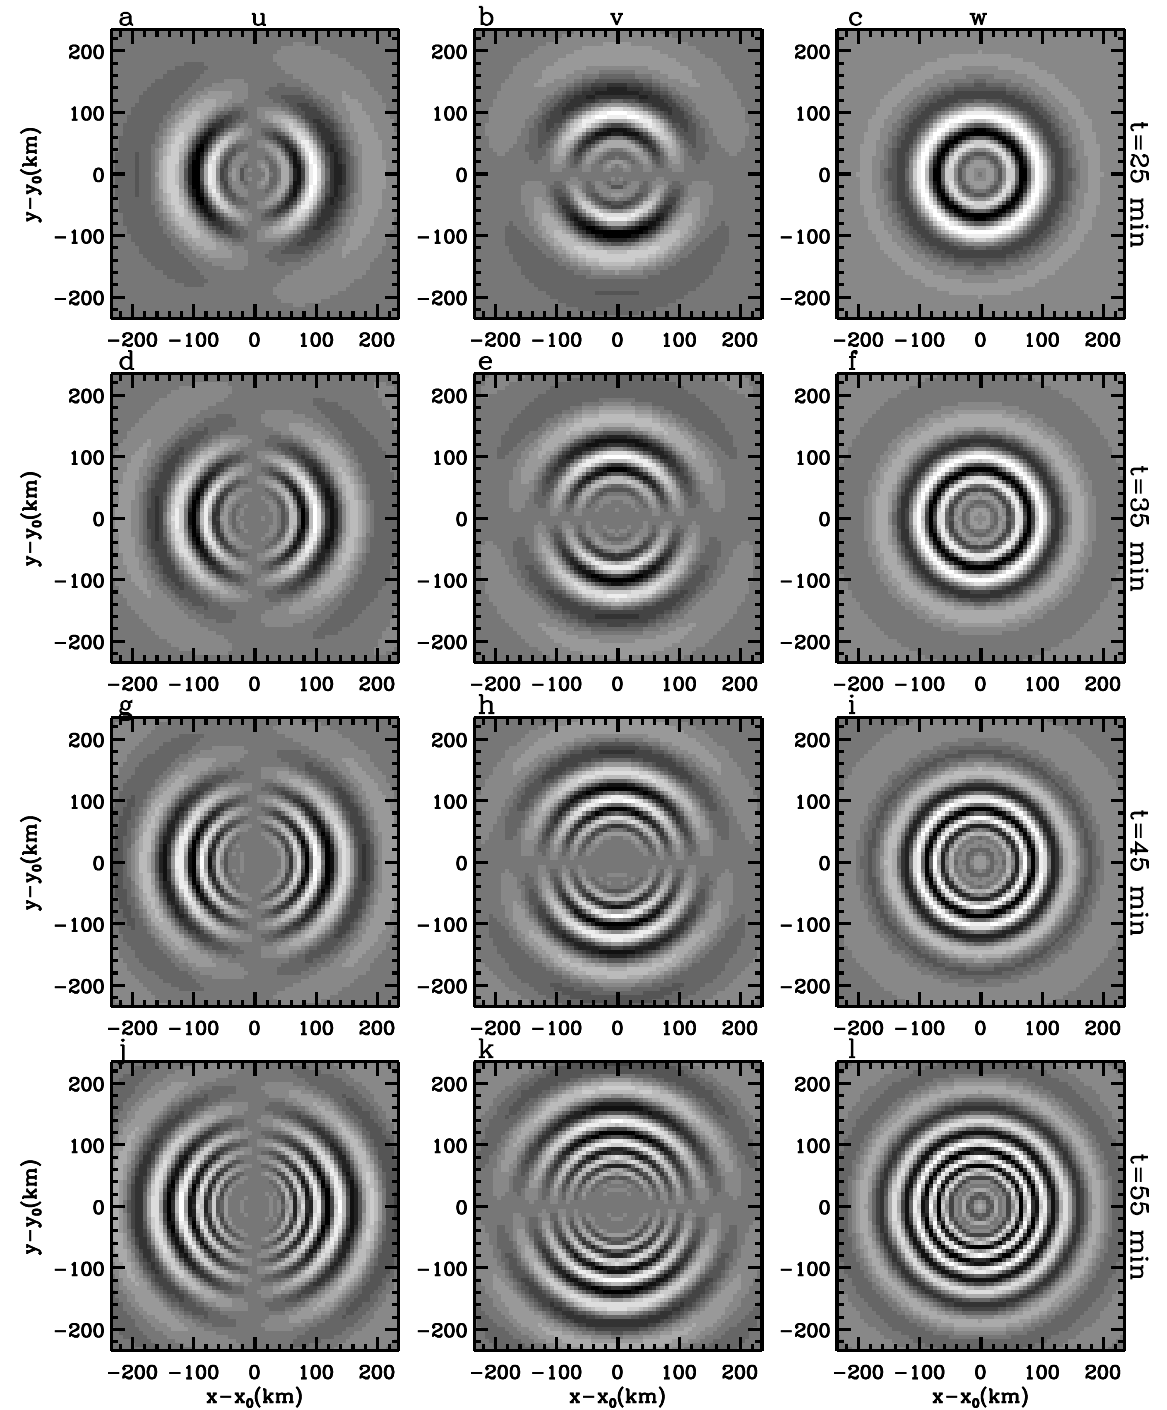
Fig. 6. Horizontal slices of u , v , and w in columns 1, 2, and 3, respectively at z = 70km for the same convective plume in Fig. 5. Rows 1– 4 show the images at times t = 25, 35, 45, and 55min, respectively. From left to right, the maximum values (scaled for the decreasing background density) for the u and w images are: 1st row: 8 and 6ms − 1 . 2nd row: 15 and 12ms − 1 . 3rd row: 18 and 14ms − 1 . 4th row: 17 and 11ms − 1 . The maxima for the v images are identical to those of the u